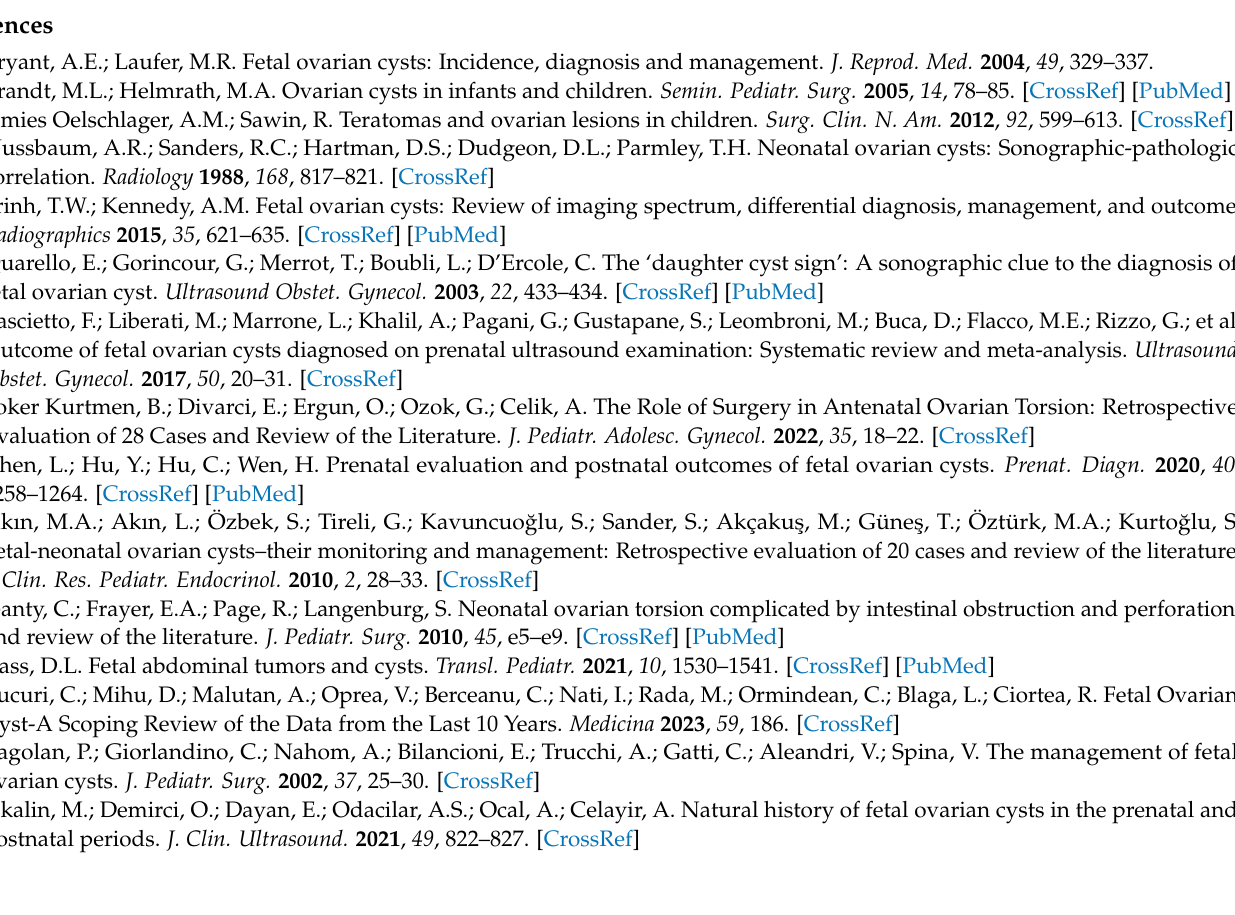
fetal ovarian cyst. Figure S2: Bilateral simple fetal ovarian cysts. Figure S3: Complicated simple serous cyst. Figure S4: Fetal teratoma. Figure S5: Large